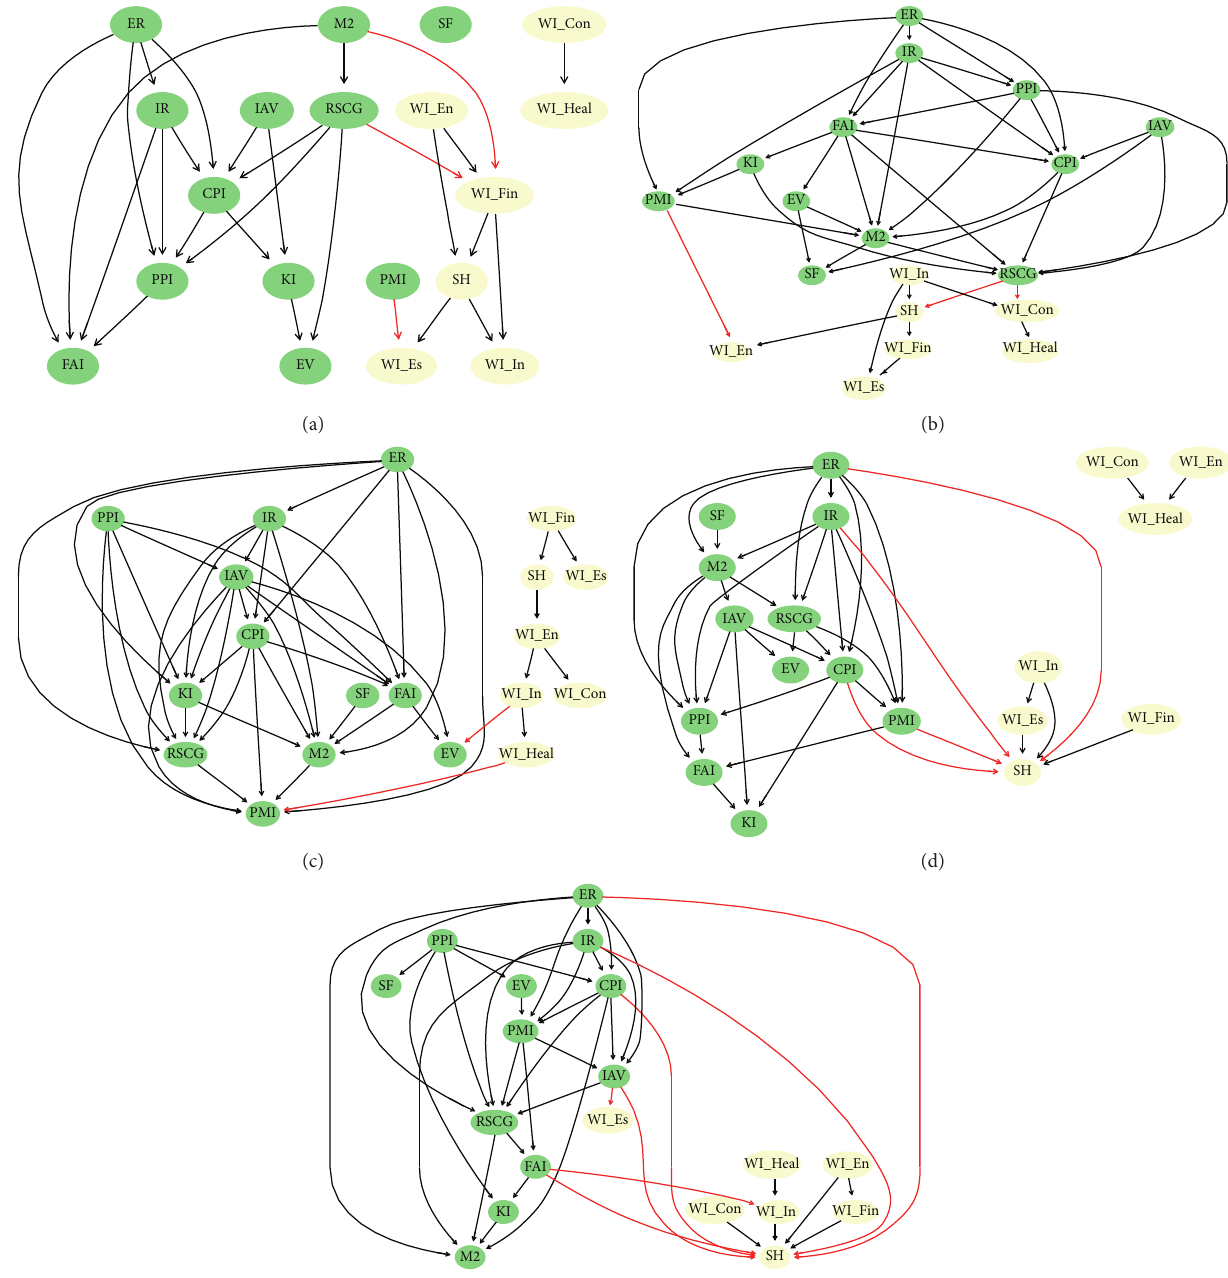
Figure 3: Bayesian network structure: (a) 2010-07; (b) 2012-11; (c) 2014-03; (d) 2016-12; (e) 2017-07 (red arrows indicate the linking